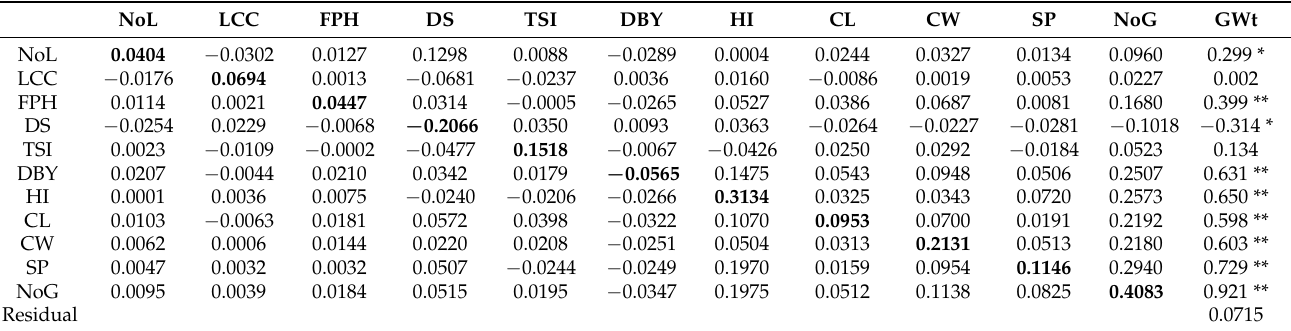
Table 4. Direct (bold diagonal) and indirect effects of selected maize growth and yield traits on grain weight under the heat-stress (HS)